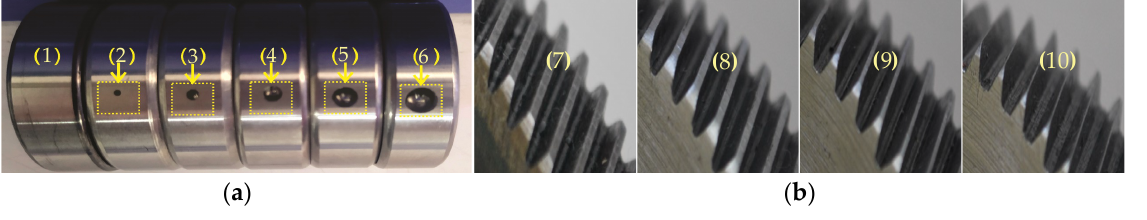
Figure 2. Fault conditions and their graduality, in ( a ) outer-race faults of the rolling bearings, and in ( b ) tooth wear of a gear into the gearbox.